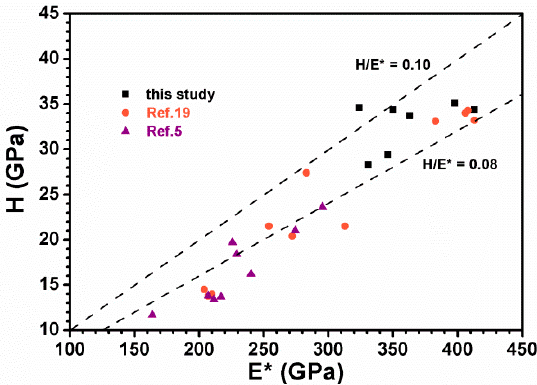
Figure 10. Relationship between hardness ( H ) and effective Young’s modulus ( E* ) of the Zr–Si–N coating.